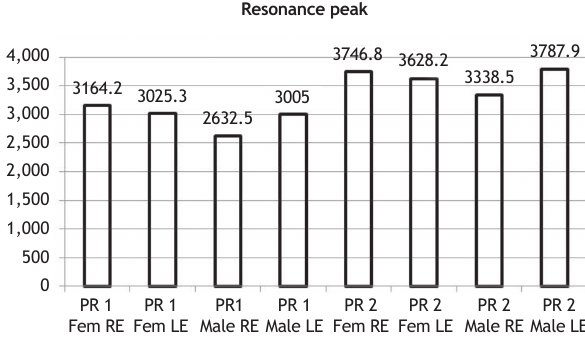
Figure 7 Resonance peaks. PR1, resonance peak with an open ear; PR2, resonance peak using IE; RE, right ear; LE, left ear.